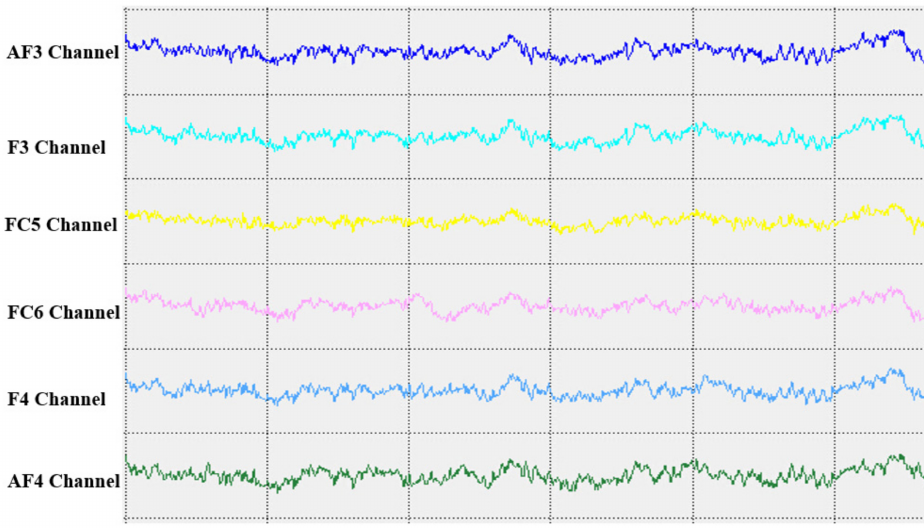
Figure 2. Six-channel electroencephalography (EEG) waveforms from a female subject.